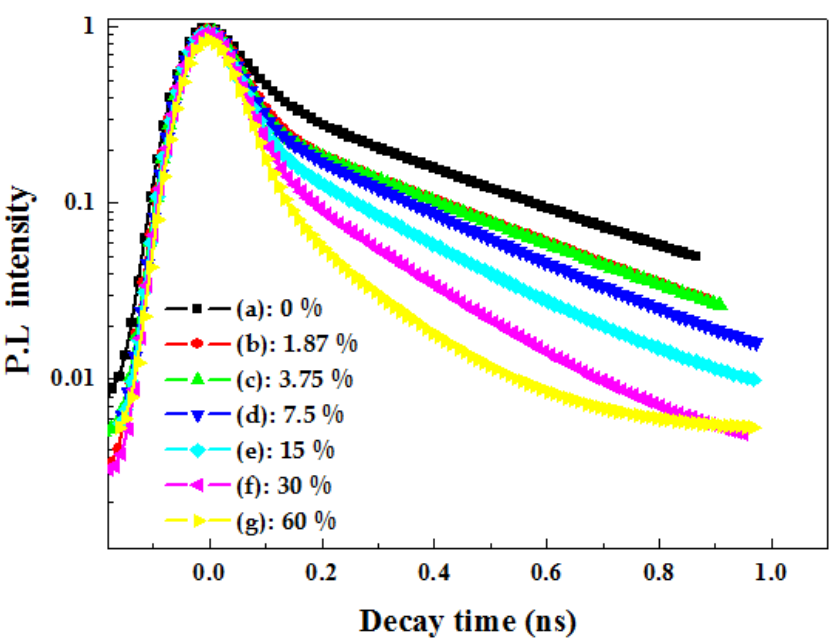
Figure 12. Time-resolved PL decays of PVK-HTs functionalized with SWCNTs at different concentrations: ( a ) 0%, ( b ) x = 1.87%, ( c ) 3.75%, ( d ) 7.5%, ( e ) 15%, ( f ) 30%, and ( g ) 60%.